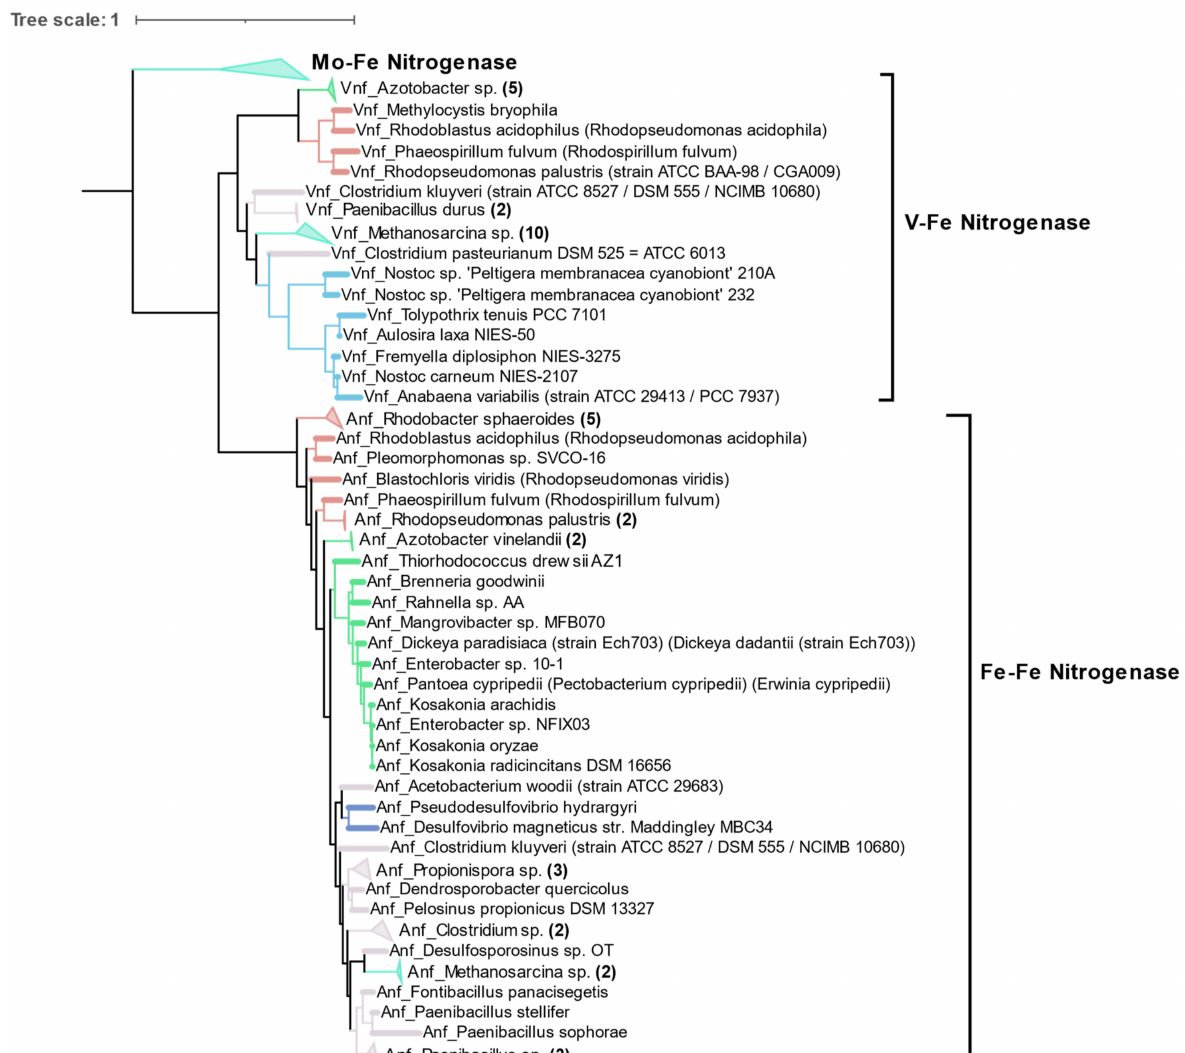
Figure 8. Cluster III of the concatenated AnfHDK/VnfHDK tree obtained by FASTTREE, showing the phylogenetic relationship between isolates carrying alternative forms of